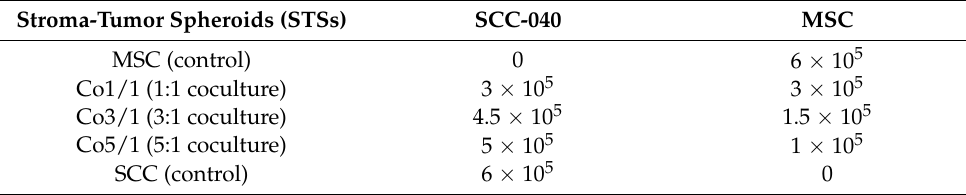
Table 1. Proportions of cell types used to create different STSs as mono- and cocultures. Stroma-Tumor Spheroids (STSs) SCC-040 MSC MSC